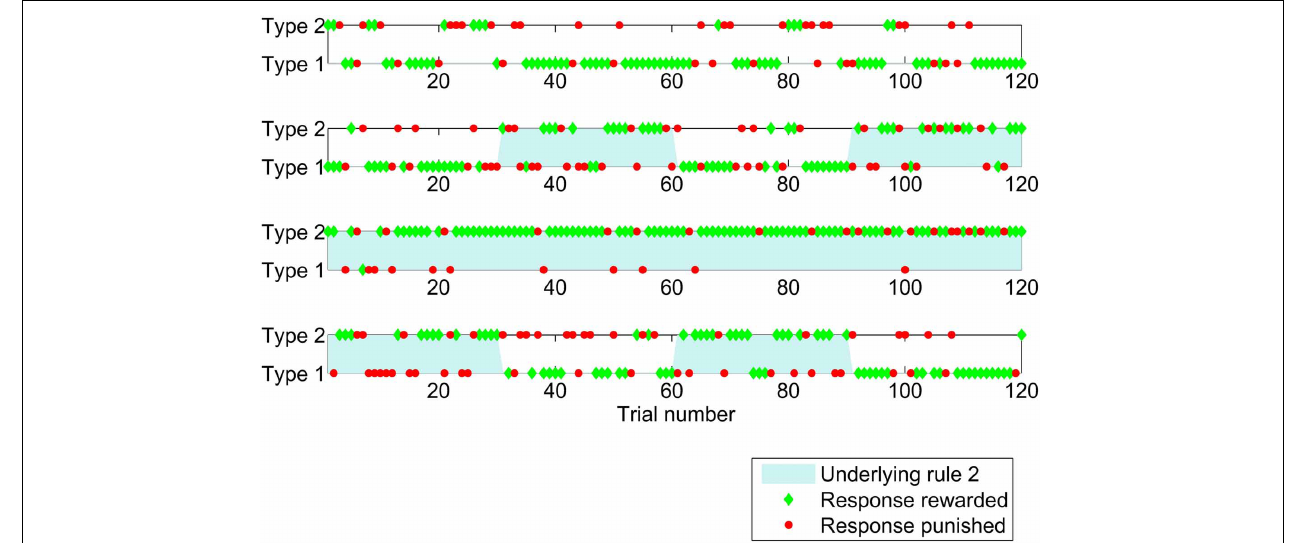
FIGURE 1 | Sequence of responses (a type 1 response is to press button one when a red triangle is shown and button two for blue, with type 2 the opposite) given by four participants for the first 120 trials of the study which had probabilistic feedback. Responses which were positively